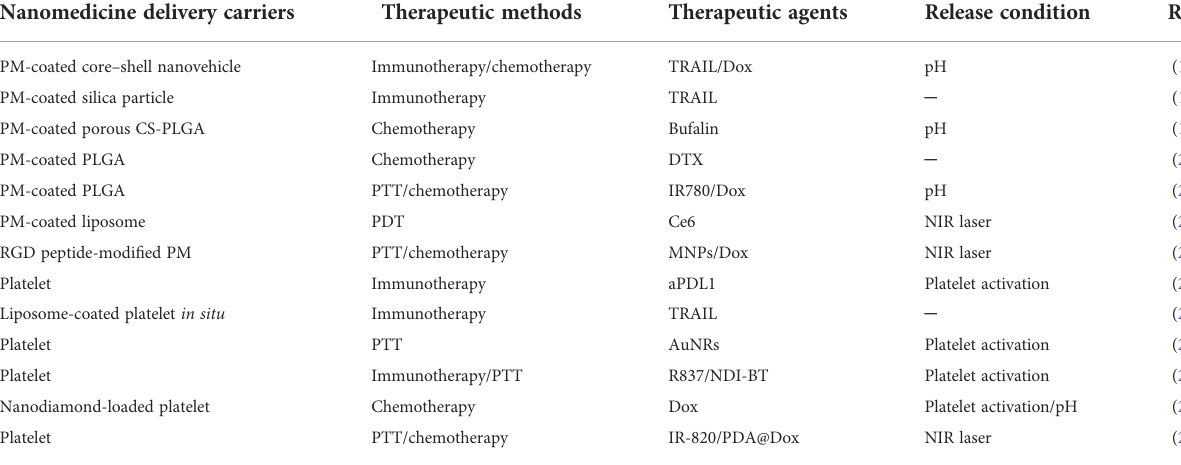
TABLE 1 PM and platelet for nanomedicine